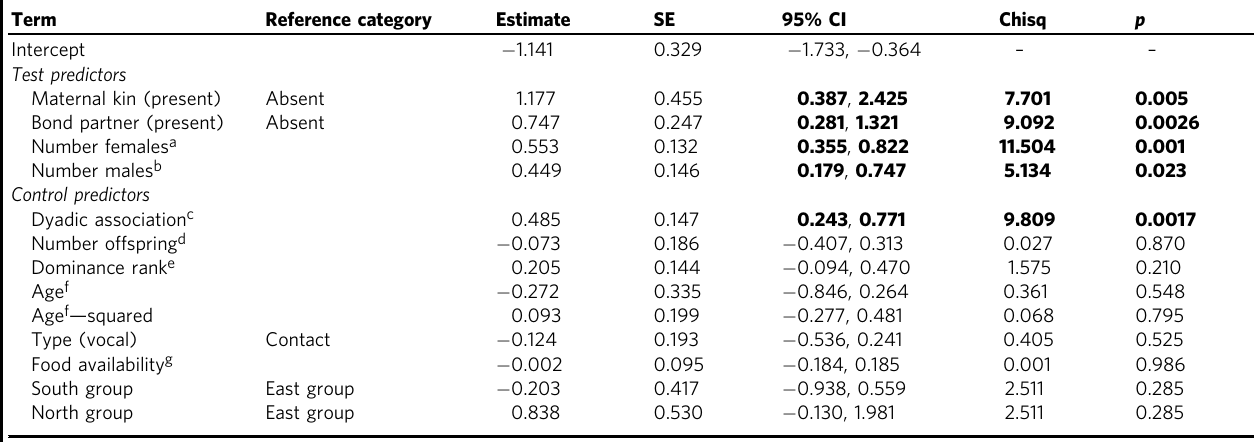
Table 2 ‘ Male participation ’ GLMM testing the effect of strength in numbers and predictability of coalitionary support on participation likelihood ( N = 342 encounters, 36 adult male